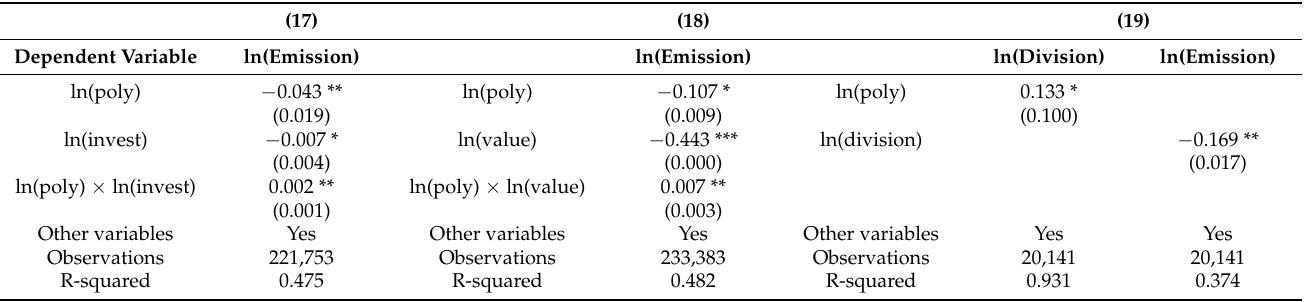
Table 7. Results of the mechanism